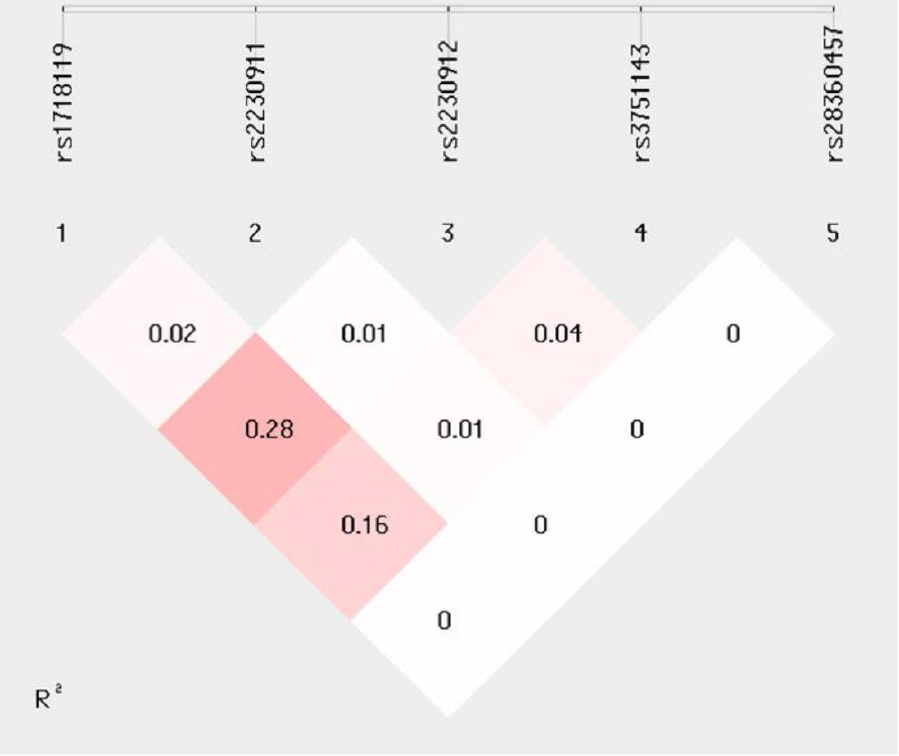
Figure 1. Linkage disequilibrium analysis (R 2 ) for five P2X7R SNPs: rs1718119, rs2230911, rs2230912, rs3751143, and rs28360457.